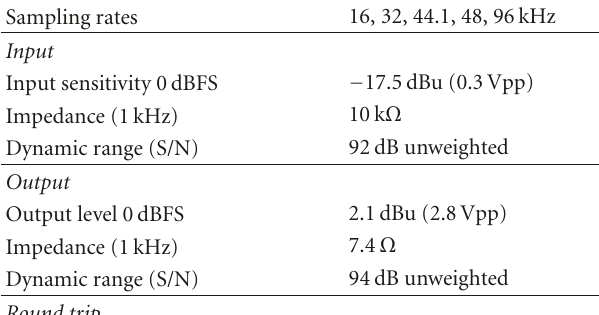
Table 3: Evaluation results of the dedicated audio interface. As a reference device for the dynamic range measurements, an RME ADI8 Proconverter has been used. The minimal delay depends not only on the sampling rate (and thus on the length of the anti- aliasing filters) but also on the achievable minimal block